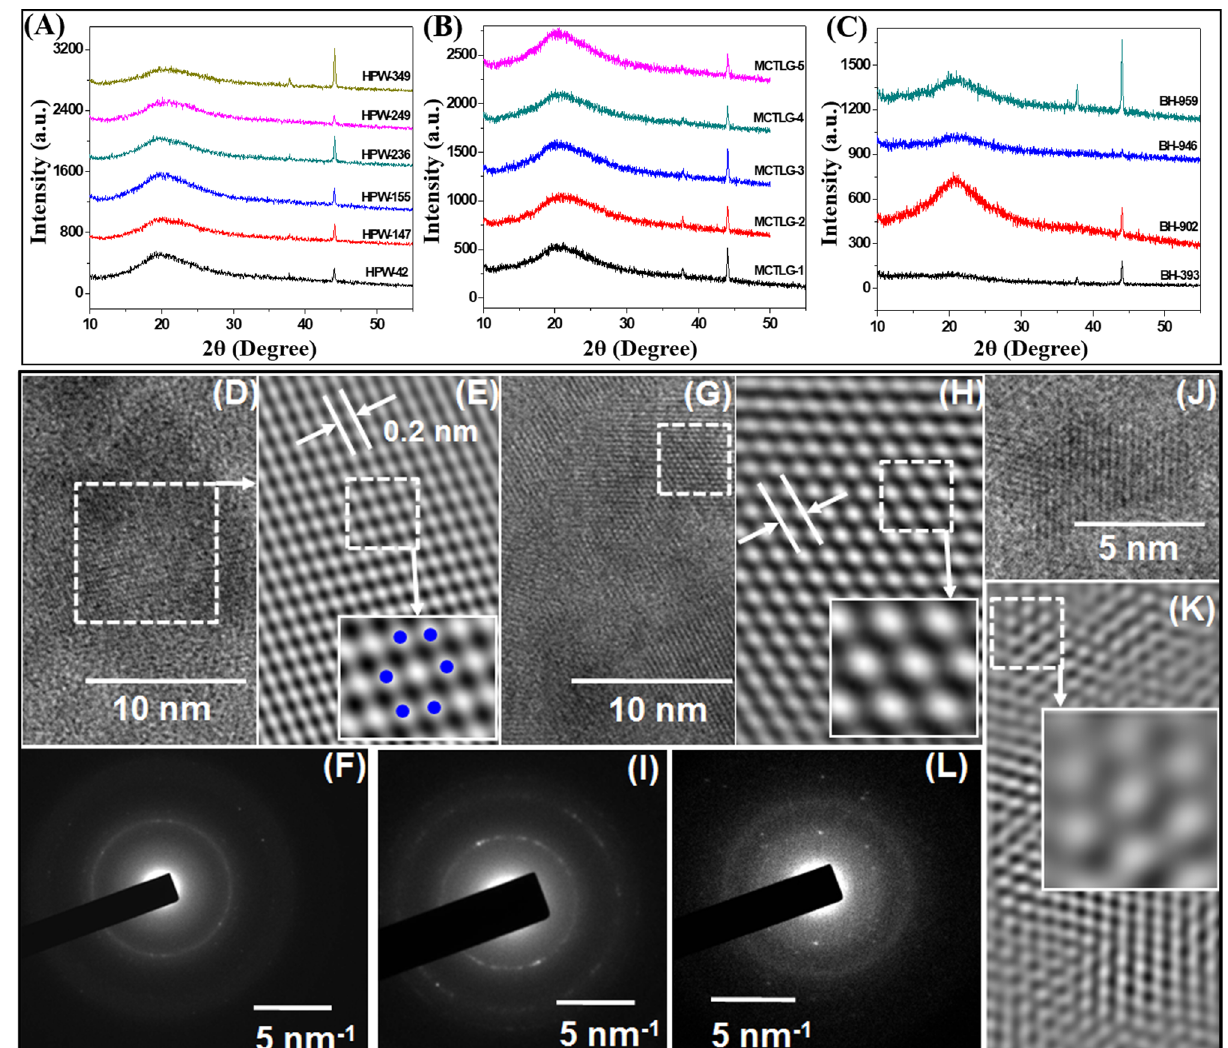
Figure 5. X-ray diffractograms of ( A ) Gliadin, ( B ) Secalin and ( C ) Hordein. HRTEM image of ( D ) HPW-42 Gliadin, ( E ) is digitally filtered image of area highlighted in ( D ). ( G , H ) correspond to Secalin, MCTLG-5 and ( I ) and ( K ) correspond to Hordein, BH-393. ( F , I , L ) are respective selected area electron diffraction pattern from Gliadin, Secalin and Hordein. These images were taken from respective HRTEM image area shown in ( A , G , I ). Note that in all images digitally filtered images are produced from highlighted area in respective HRTEM images as shown in Figure P (0.84–1.31%), Na (0.42–1.18%) and I (1.97–4.56%). The weight percentage is considered when contribution of each element to the total weight of the molecule is important. The EDX analysis suggested that the gliadin fraction consisted of C, N, O with traces of S and P, Na and I were detected possibly due to NaI salt used in the extraction procedure. This implies that the relative ratio of C:O:N:S (weight percentage) in prolamin followed the ascending order, being higher in hordein (113:156:43:1), followed by secalin (110:76:21:1) and gliadin (77:48:24:1). It was noted that O is two times the amount of N in gliadin fraction while 3.6 times in secalin and hordein fractions. X‑ray diffraction (XRD). XRD is the primary and most widely employed technique to examine the micro- structural properties of various compounds. The XRD patterns of different prolamin fractions are presented in Fig. 5a–c & S7. A broad hump at around 20° indicated the amorphous nature of all the samples which was also reported by Jia et al. 20 in gliadin. High Glu and Pro content was observed in prolamin fractions and significant contamination of extracted prolamin with albumin + globulin which might have contributed to this amorphous structure 66 . The outcome of Ebrahimi et al. 67 also supported this finding and showed the presence of broad hump around 20° in XRD pattern of pure BSA, but crystalline peaks were not observed in 5–40 o diffraction 2θ scan. Prolamin fractions from different cultivars showed diffraction peaks at 2θ values of 10.4°, 37.8° and 44.1° which indicated the existence of a regular periodic arrangement of molecules or crystallinity.